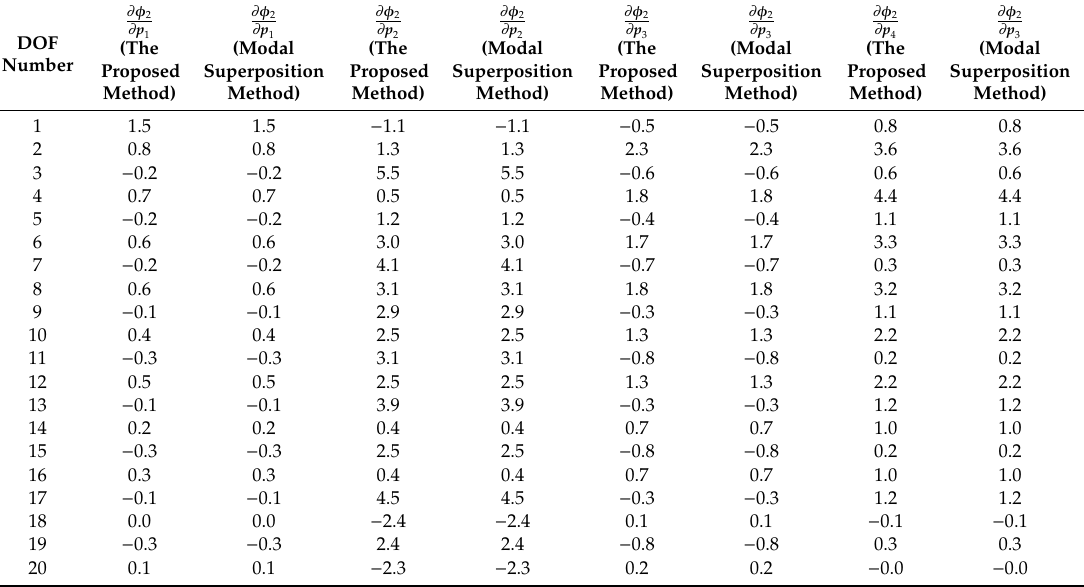
Table 2. Comparison of the calculation results for the second eigenvector sensitivity ( × 10 − 3 ). DOF Number